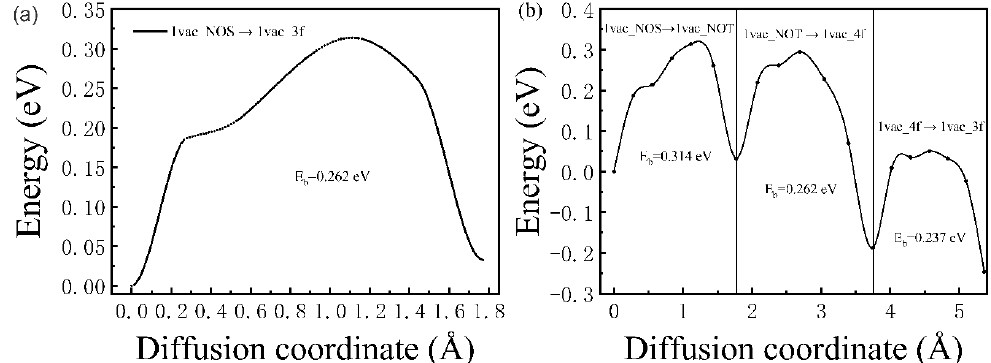
Figure 4. Diffusion pathways from ( a ) T-site to T-site (T-T) and ( b ) O-site to O-site (O-O) in bulk Pd. Figure 5. The corresponding di ff usion barrier energies of ( a ) 1vac_NOS → 1vac_3f and ( b ) 1vac_NOS The corresponding diffusion barrier energy of ( c ) T-T and ( d ) O-O. Figure 5. The corresponding diffusion barrier energies of ( a ) 1vac_NOS → 1vac_3f and ( b ) 1vac_NOS → 1vac_NOT → 1vac_4f → 1vac_3f. → 1vac_NOT → 1vac_4f → 1vac_3f.